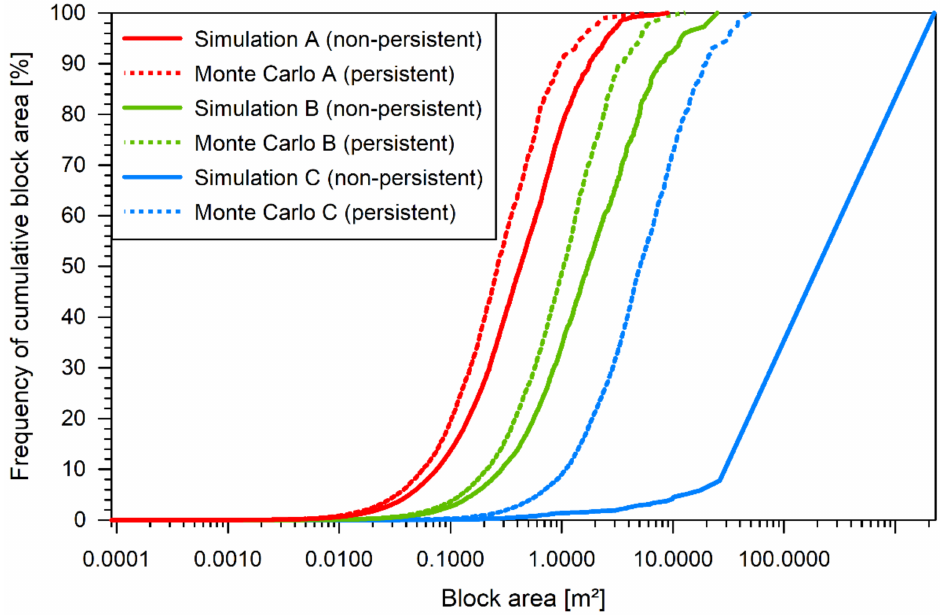
Figure 4. Selected examples of block area simulations, assuming non-persistent fractures (solid lines) and block area distributions, assuming persistent fractures (Monte Carlo simulation based on Equation (1), dashed